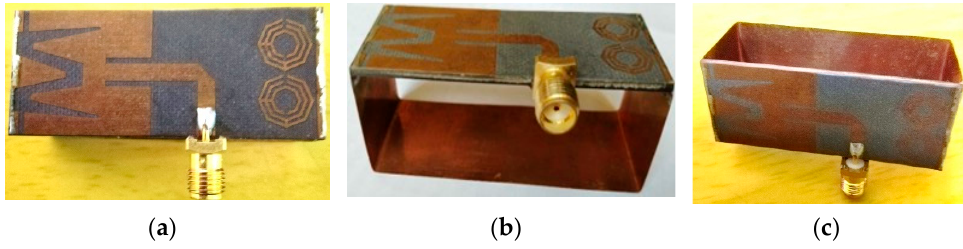
Figure 2. Fabricated prototype of the SNTSRR MTM-loaded 3D antenna; ( a ) top view; ( b ) side view; ( c ) perspective view.